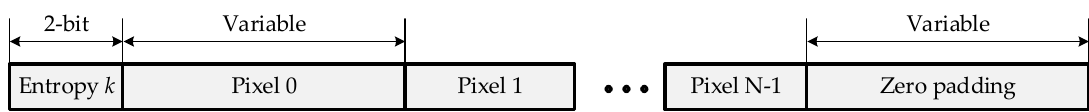
Figure 6. Payload structure.